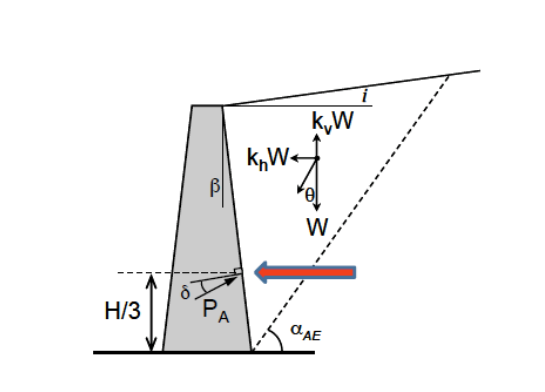
Figure 1. Wall load during quasi-static